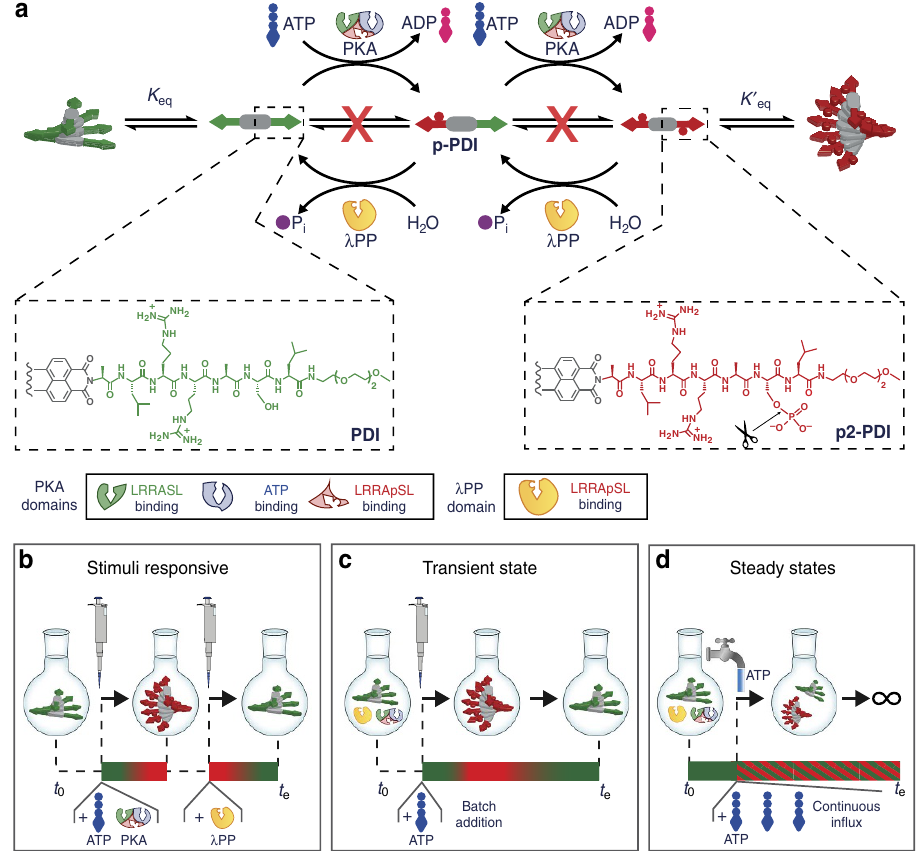
Figure 1 | Enzyme-controlled supramolecular polymerization from stepwise to steady states. ( a ) Peptide–perylenediimide derivative PDI (half is shown) is phosphorylated on the serine residue by protein kinase A (PKA) to give monophosphorylated p-PDI , and further diphosphorylated p2-PDI , fuelled by ATP to ADP hydrolysis (one eq. per phosphate introduced). Phosphate hydrolysis (scissors) by l -protein phosphatase ( l PP) yields inorganic phosphate Pi as waste. Both PDI and p2-PDI can self-assemble to form equilibrium supramolecular polymers. PKA has three binding sites: for ATP (blue), for the LRRASL peptide (green) and for LRRApSL (red). ( b ) Stimuli responsiveness: the addition of ATP and PKA to a solution of PDI results in p2-PDI and a consequent change of the supramolecular structure of the polymer. A second stimulus, that is, the addition of l PP, is needed to reset the polymer to its original nonphosphorylated state. ( c ) Transient state: a single input, that is, the addition of ATP to a solution of PDI , in the presence of PKA and l PP, leads to a transient change of the supramolecular structure and chirality of the polymer. ( d ) Supramolecular non-equilibrium steady states (NESS). The system is kept in a dissipative steady state by continuous influx of ATP. Depending on the level of the chemical fuel supplied different dissipative steady states can be